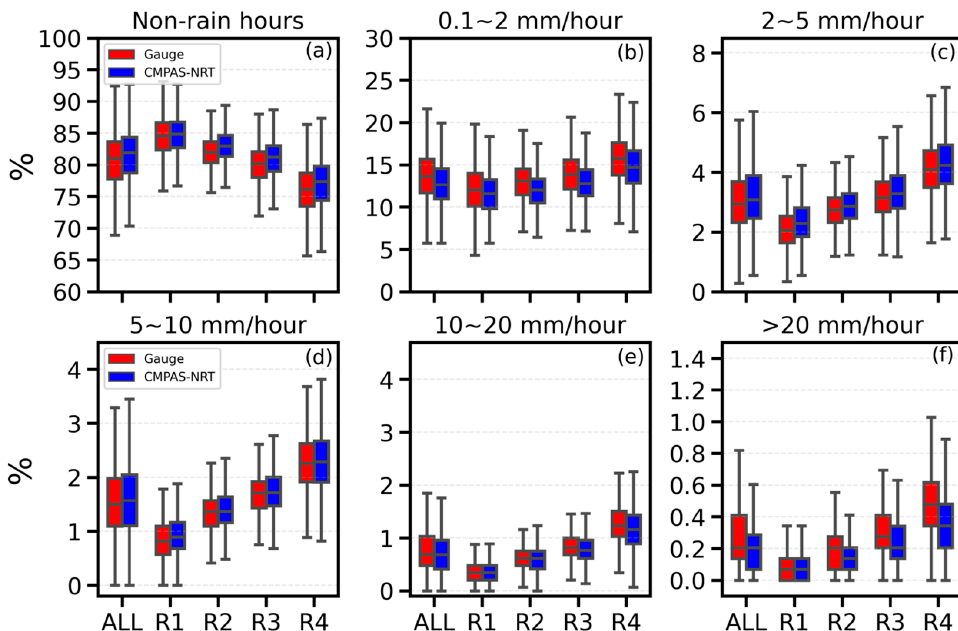
Figure 11. Relative contribution of precipitation occurrence times recorded by surface rain-gauge observations (red) and CMPAS-NRT products (blue) to the total precipitation occurrence times (including each sub-region and the whole region) during the whole rainy period in 2020 at different hourly precipitation threshold intervals. Panels ( a – f ) respectively represent hourly precipitation thresholds of 0, 0.1–2 mm/h, 2–5 mm/h, 5–10 mm/h, 10–20 mm/h, and >20 mm/h.